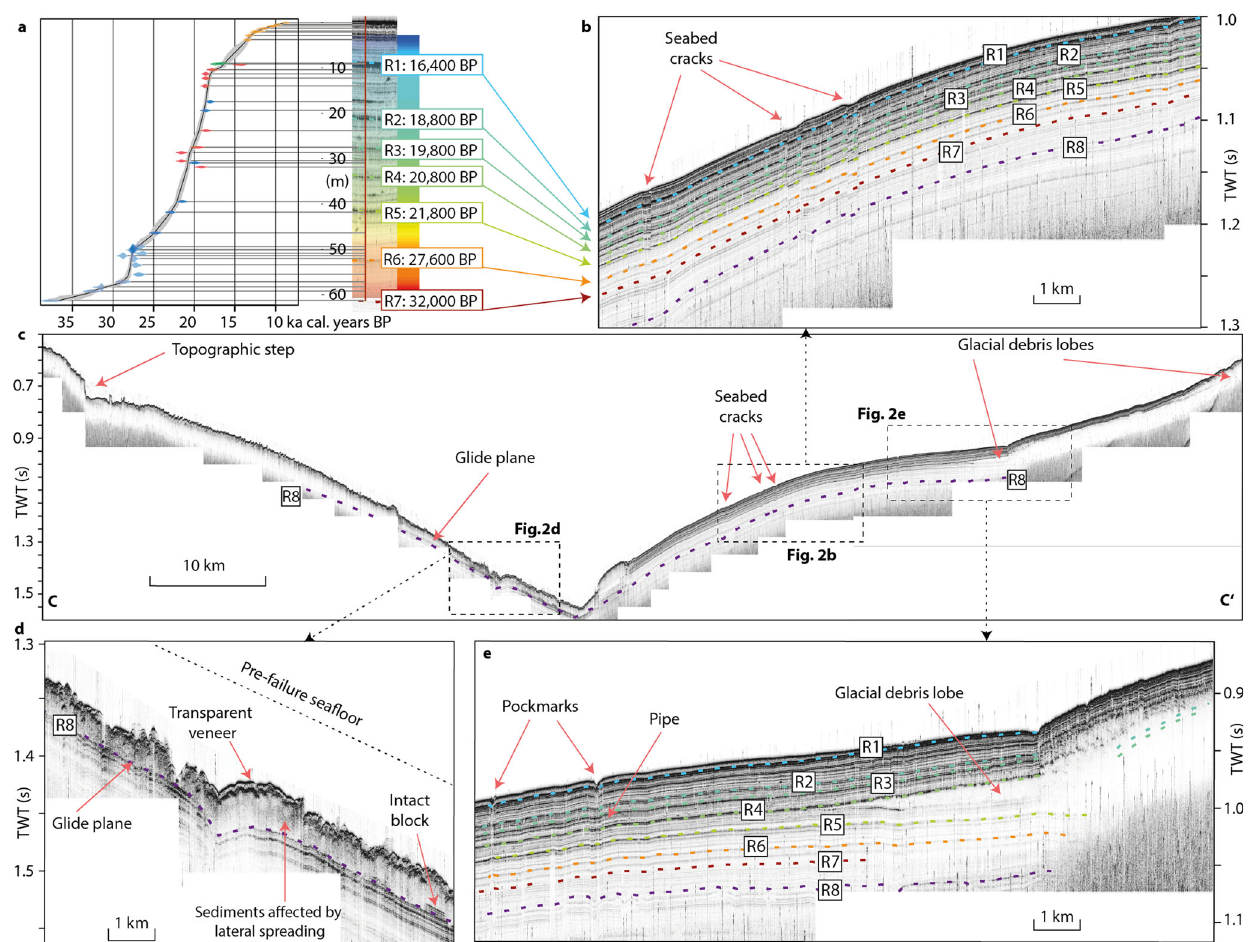
Fig. 2 Reference core chronostratigraphy and sediment echosounder pro fi les from the northern sidewall of the Storegga Slide. a Age-depth model for key horizons R1 to R7 for the northern sidewall of the Storegga Slide Complex from ref. 14 . b Echosounder pro fi le showing the intact sidewall stratigraphy with key horizons R1 to R8 and sea fl oor cracks annotated. c Echosounder pro fi le crossing the Storegga Slide and the intact side wall showing horizon R8, and the location of enlargements b, d and e. d Echosounder pro fi le showing the chaotic, transparent sediments covering R8 with small intact block and a thin transparent veneer, the Storegga Slide glide plane, and the extrapolated pre-Storegga sea fl oor depth (dashed black line). e Echosounder pro fi le showing the intact sidewall stratigraphy with key horizons R1 to R8, glacial debris lobe, as well as pockmark and pipe structures.